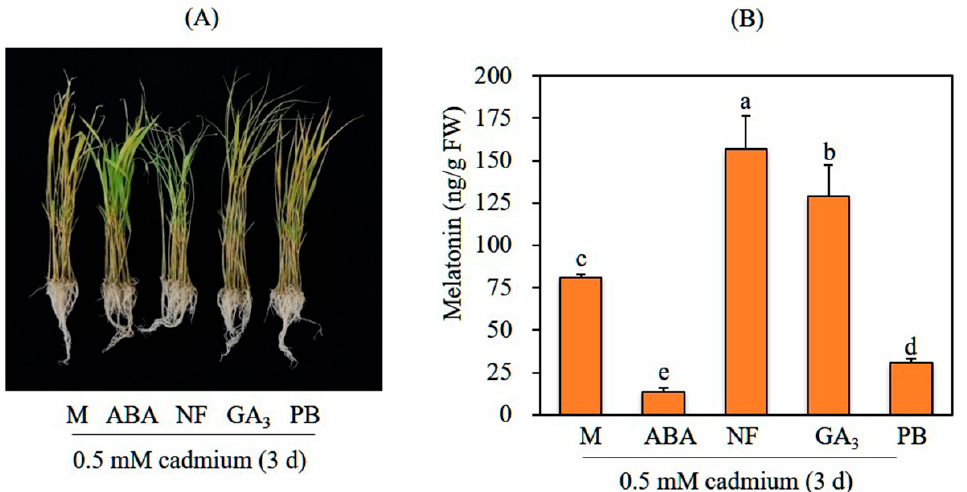
Figure 1. Melatonin content in response to plant hormones. ( A ) Phenotypes of 7-day-old rice seedlings after hormone and cadmium treatments. ( B ) Melatonin content. Seven-day-old rice seedlings rhizospherically treated with various hormones independently for 24 h, then treated with 0.5 mM cadmium for 3 days. Different letters indicate significant differences ( p < 0.05; analysis of variance (ANOVA), followed by Tukey’s honest significant difference (HSD) post hoc tests). M, water containing 0.1% ethanol; ABA, 1 µ M abscisic acid; NF, 10 µ M norflurazon; GA 3 , 10 µ M gibberellic acid 3; PB, 10 µ M